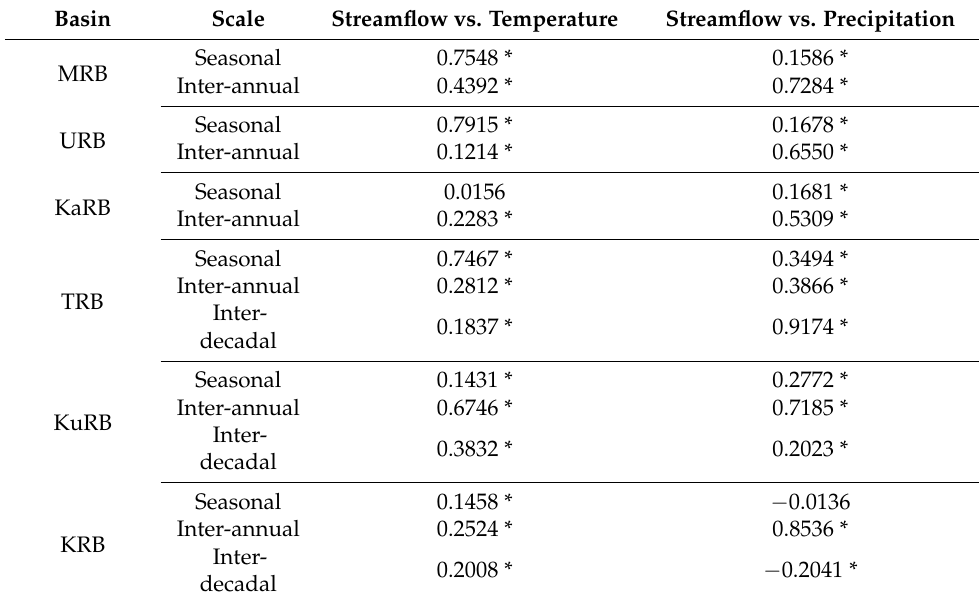
Table note: * indicates the significance of a <